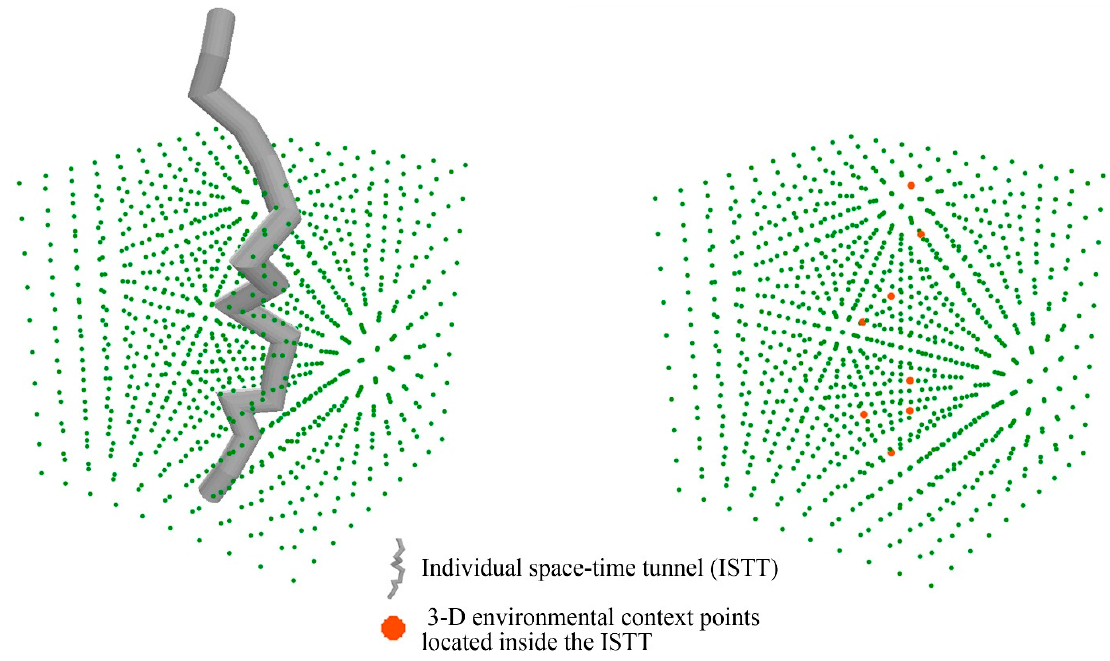
Figure 7. The 3-D intersection of the point cloud and individual space-time Figure 7. The 3 ‐ D intersection of the point cloud and individual space ‐ time tunnel.